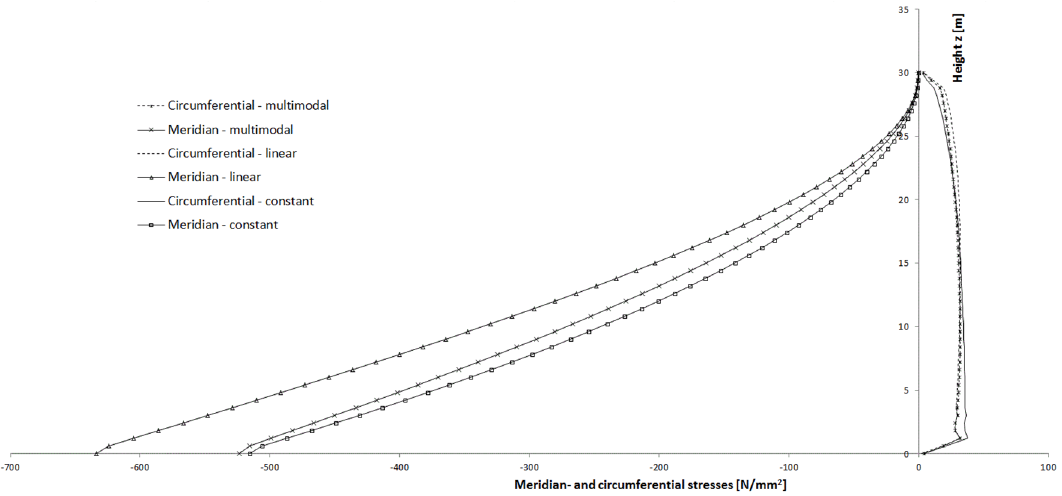
Figure 8. Circumferential and axial stresses as results of the different approaches of the acceleration.